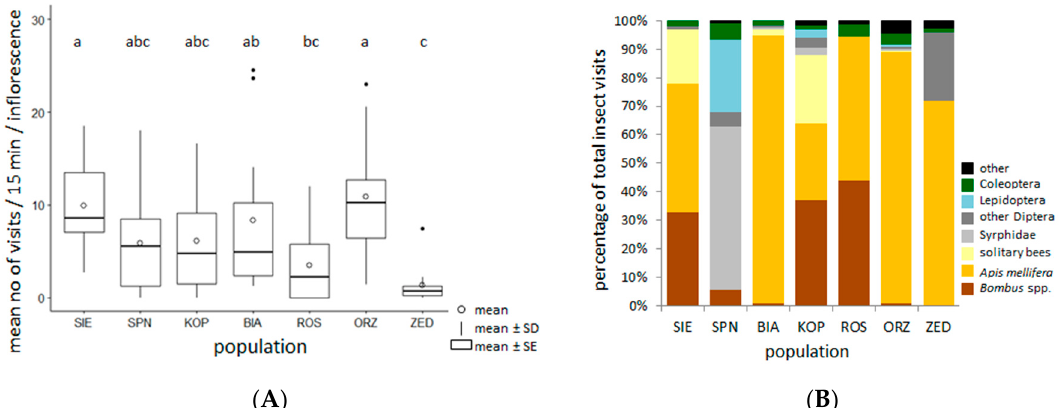
Figure 4. ( A ) Mean frequency of insect visits in seven selected populations of Polemonium caeruleum . Means with various letters are different at p < 0.05. ( B ) Taxonomic diversity of insects visiting flowers. Populations are arranged in ascending order according to their size.